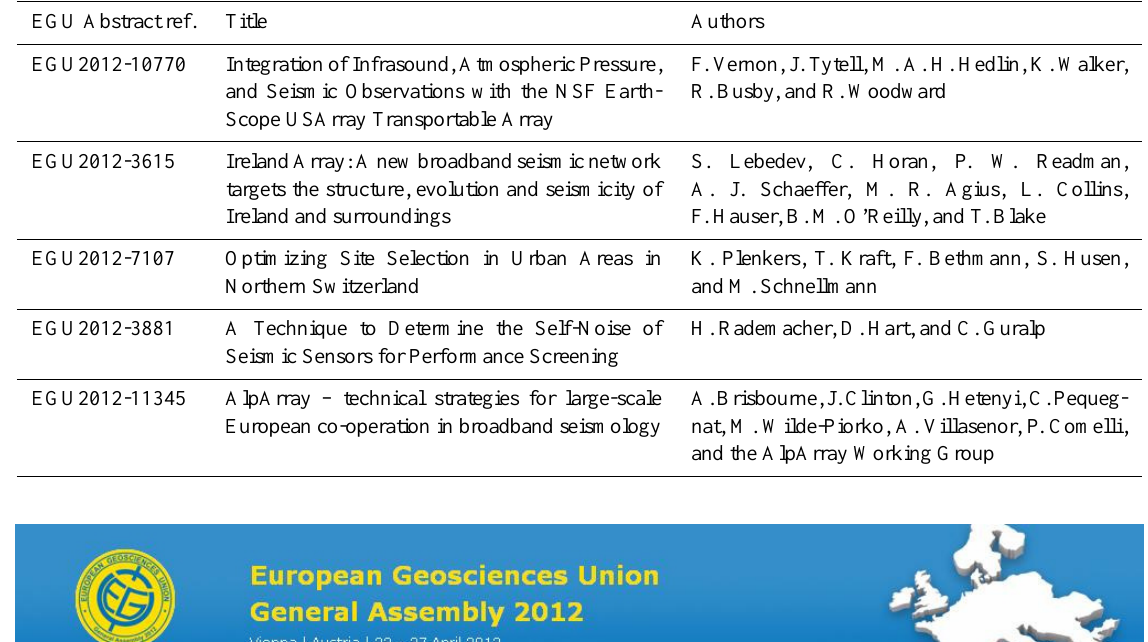
Table 1. Oral Programme SM1.3/GI1.7.